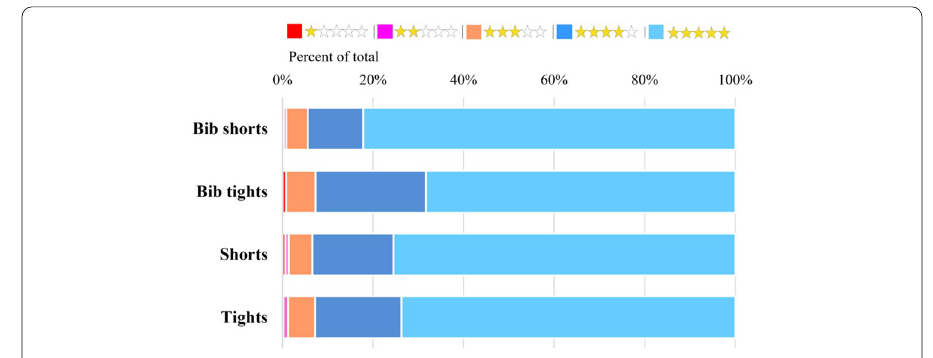
Fig. 4 Star rating of cycling